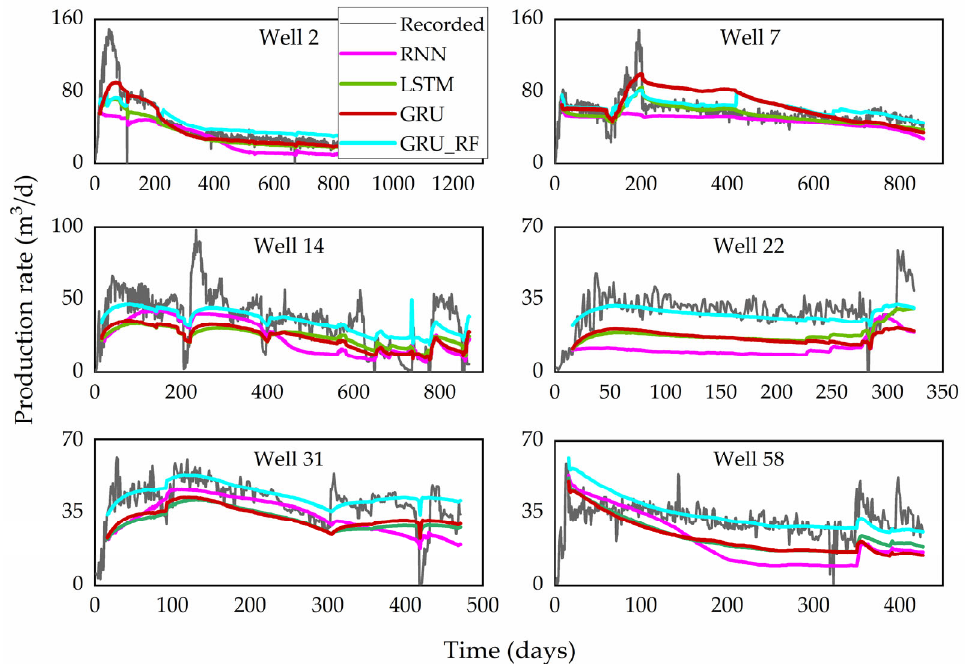
Figure 17. The predicted production of test wells with RNN, LSTM, GRU, and GRU_RF.